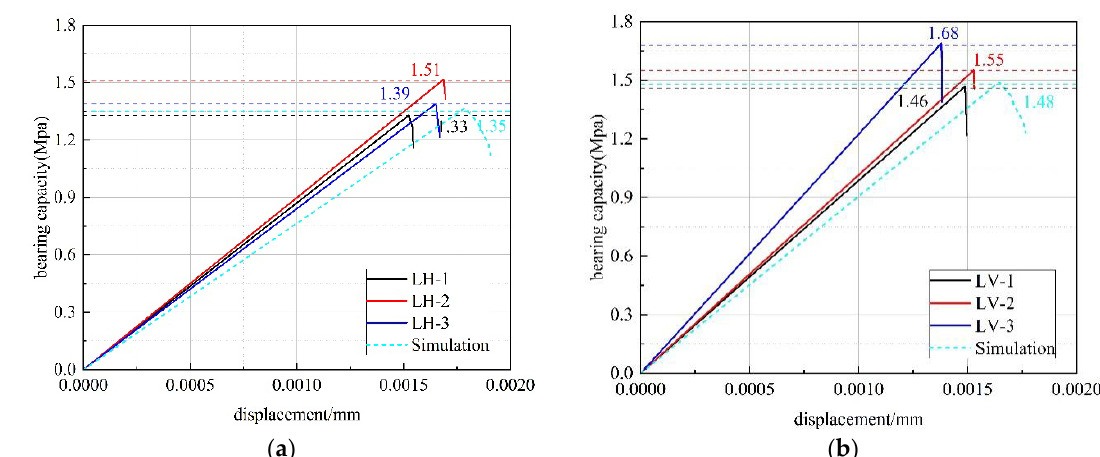
Figure 9. Analysis of grid convergence in the axial tension model. ( a ) Calculation results; ( b ) Axial tension model subjected to meshing.